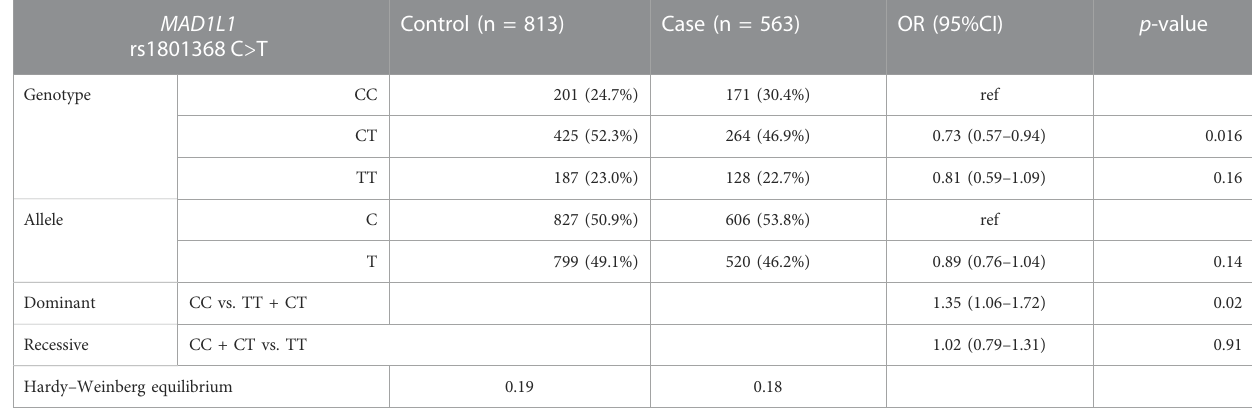
TABLE 2 Distribution of alleles, genotypes, and genetic models of the MAD1L1 rs1801368 C > T polymorphism among cases and controls.